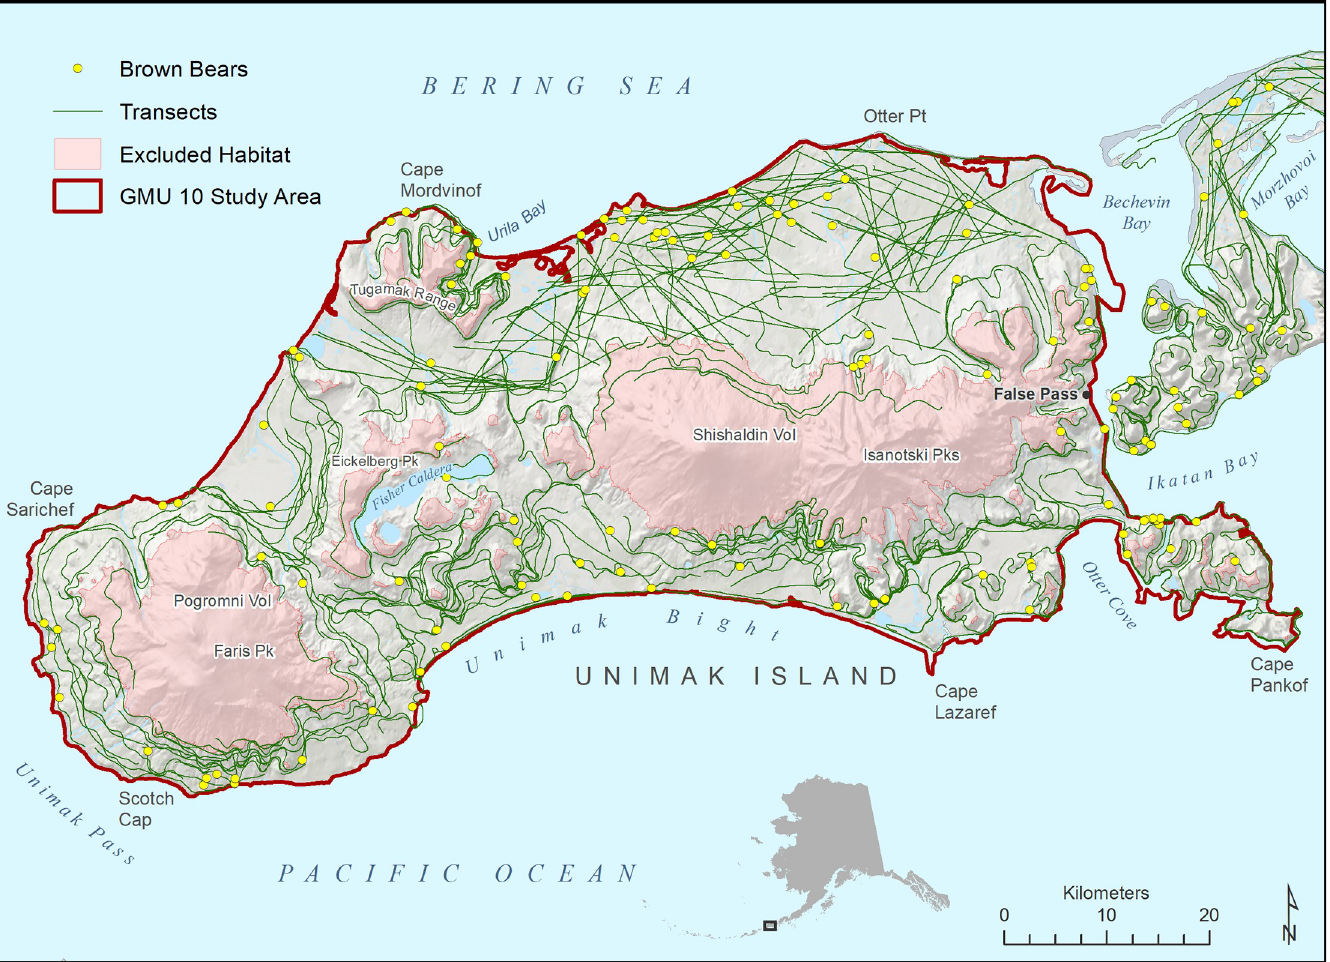
Fig 2. Game Management Unit 10 study area for a spring 2002 distance sampling survey of brown bears, Eastern Aleutian Islands, Alaska (U.S Geological Survey, National Hydrology Dataset https://www.usgs.gov/core-science-systems/ngp/national-hydrography/access-national-hydrography-products and the U.S. Geological Survey, National Elevation Dataset,